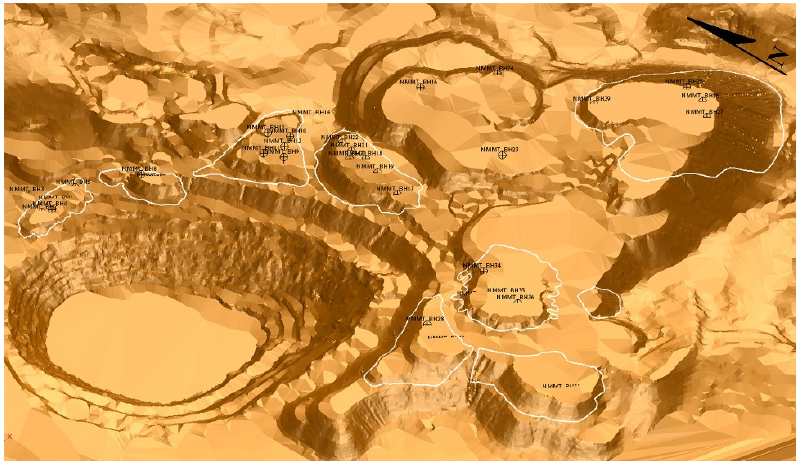
Figure 7. Locations of 39 drillholes on Mathiatis area DTM in 3D preview.